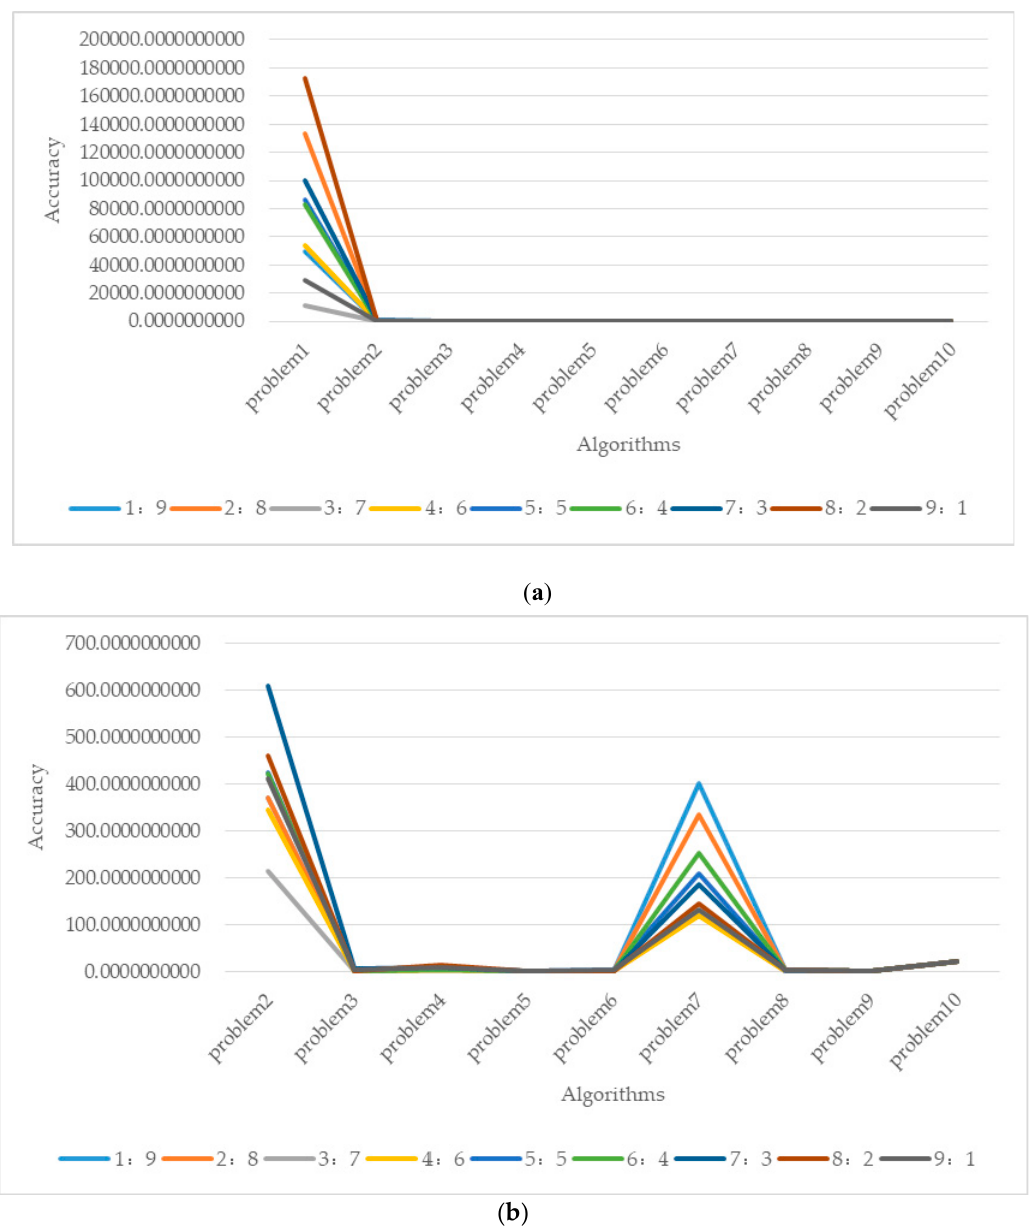
Figure 17. The di ff erent subpopulations in di ff erent problems. ( a ) The di ff erent subpopulations in Figure 17. The different subpopulations in different problems. ( a ) The different subpopulations in problems 1–10 and ( b ) the di ff erent subpopulations in problems problems 1–10 and ( b ) the different subpopulations in problems 2–10.